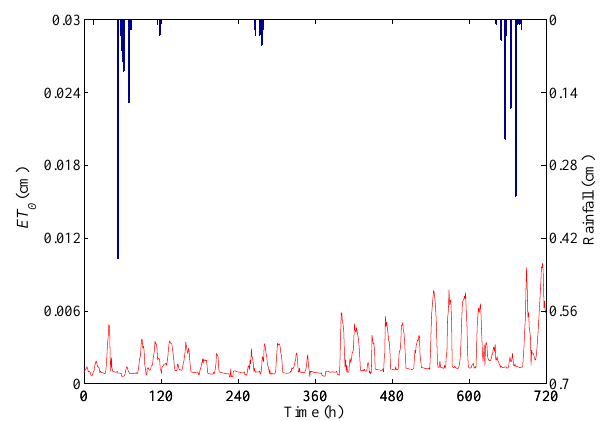
Fig.2. Rainfallandpotentialevaporationtimeseriesfrom01/04to30/04/2011inLouvain-la-Neuve(Belgium). Fig. 2. Rainfall and potential evaporation time series from 1 April to 30 April 2011 in Louvain-la-Neuve